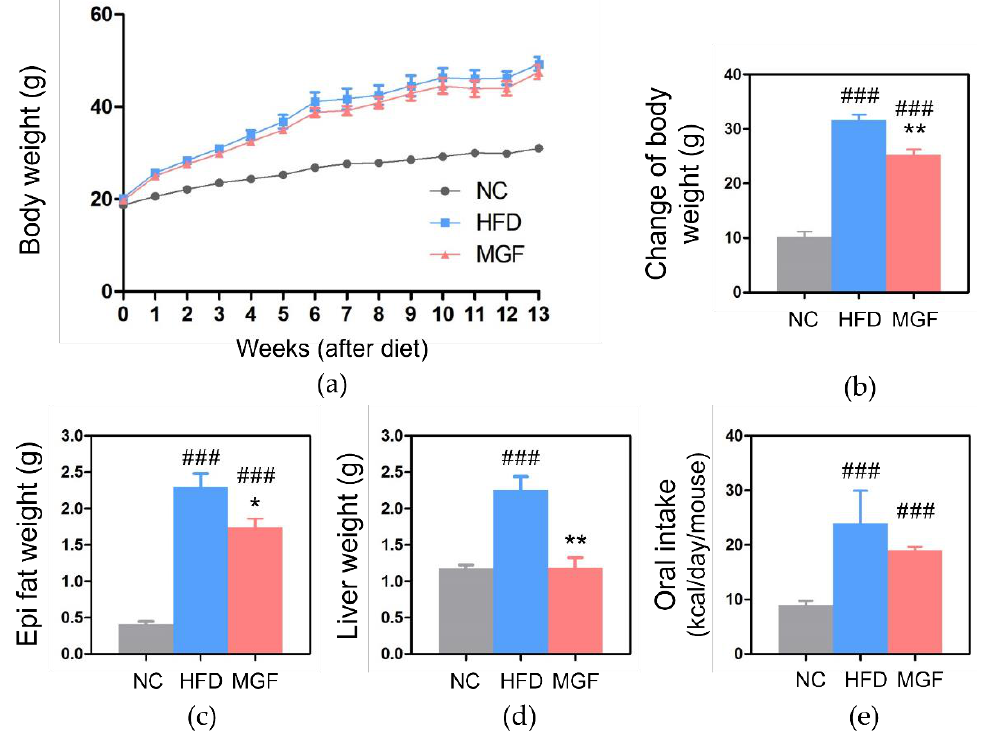
Figure 3. Weight-related indexes of each experimental group ( a ) Timeline of body weight gain. ( b ) Change in body weight. ( c ) Epididymal fat pad weight. ( d ) Liver weight. ( e ) Calorie intake. Data are expressed as mean ± standard error of mean. ### p < 0.001 indicates the results of comparison with the NC group, and * p < 0.05 and ** p < 0.01 indicate the results of comparison with the HFD group. NC, normal chow; HFD, high-fat diet; MGF, HFD + MGF 150 mg/kg/day; MGF, mangiferin.